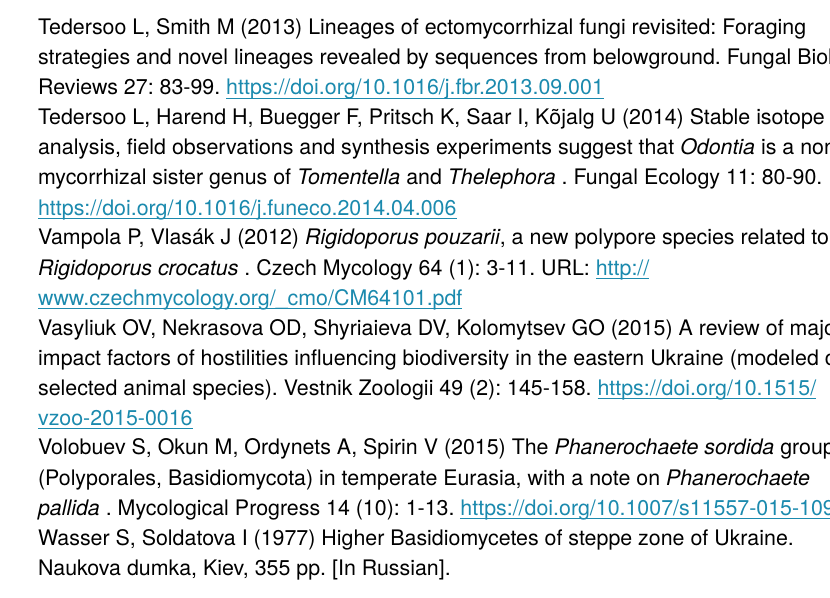
Suppl. material 1: Data resources: Aphyllophoroid fungi in insular woodlands of eastern